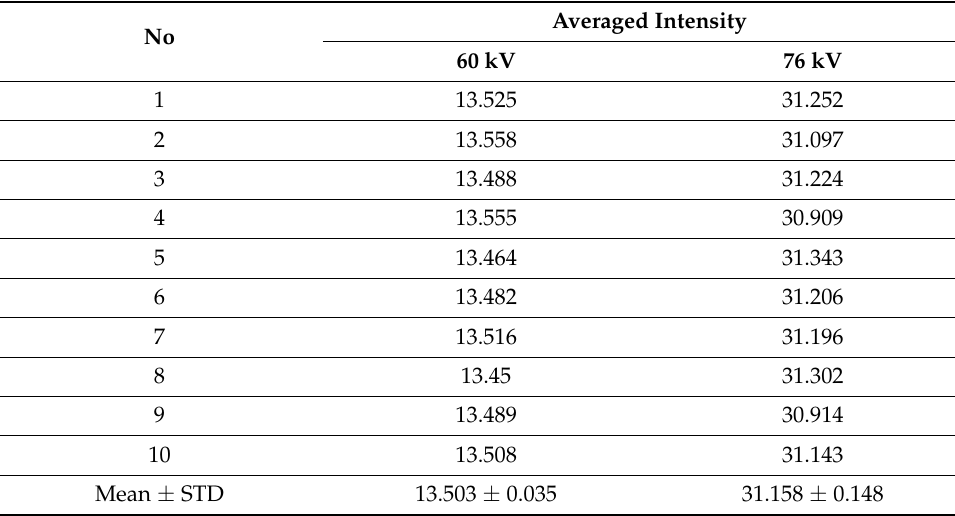
Table 2. Repeatability test of indirect X-ray